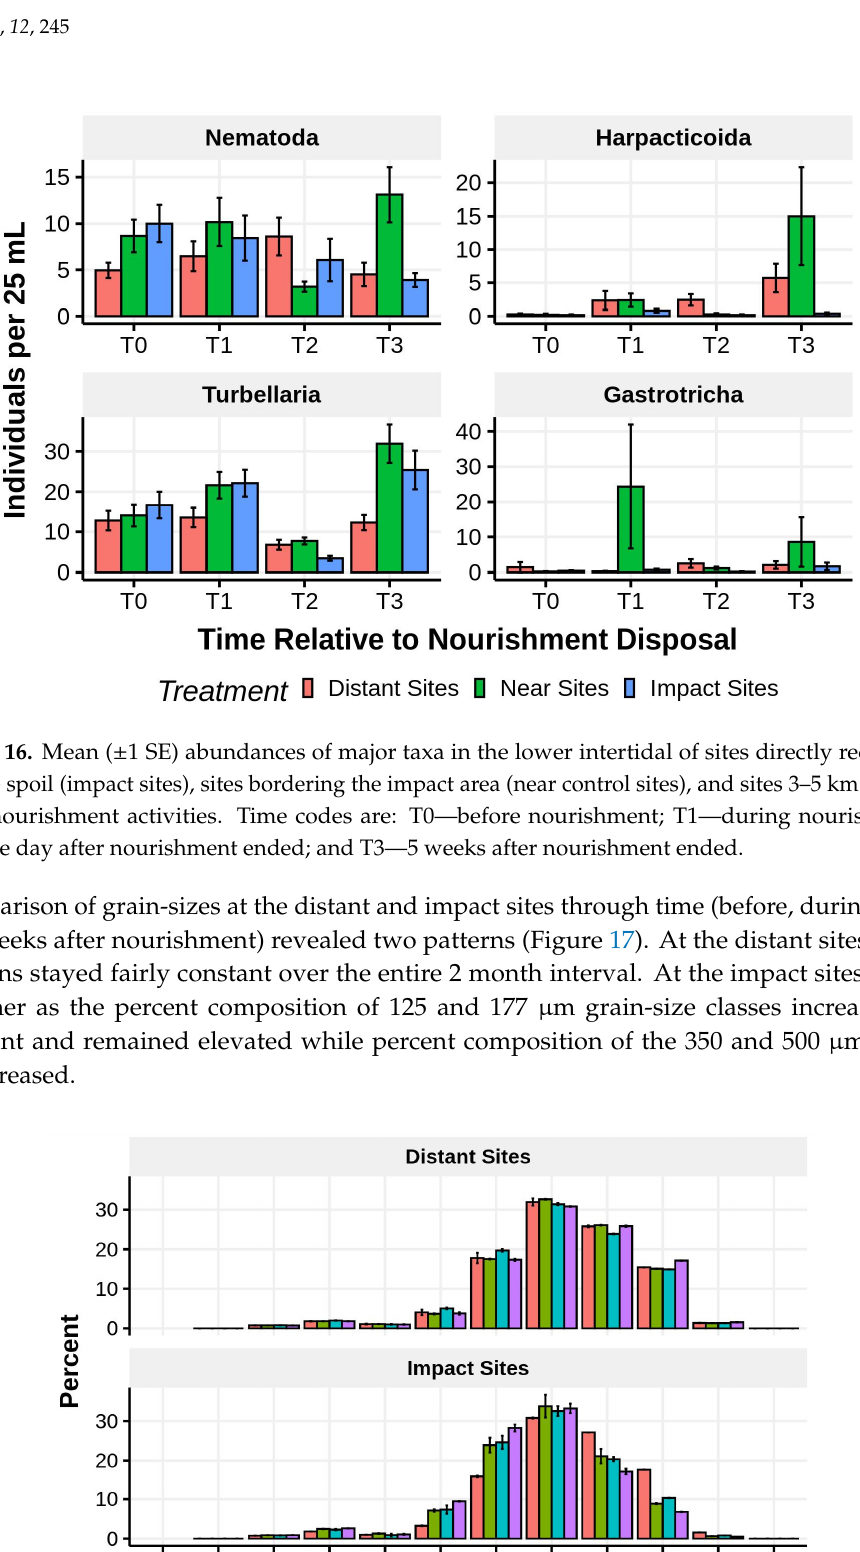
Figure 17. Mean (±1 SE) percent grain size composition of sediment samples taken from the distant and impact sites before, during, just after, and 5 weeks after nourishment.